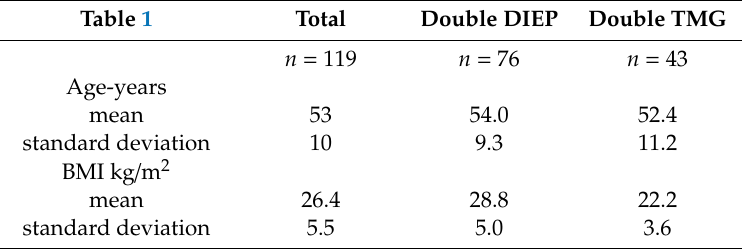
Table 1. Patient age and BMI of study groups.